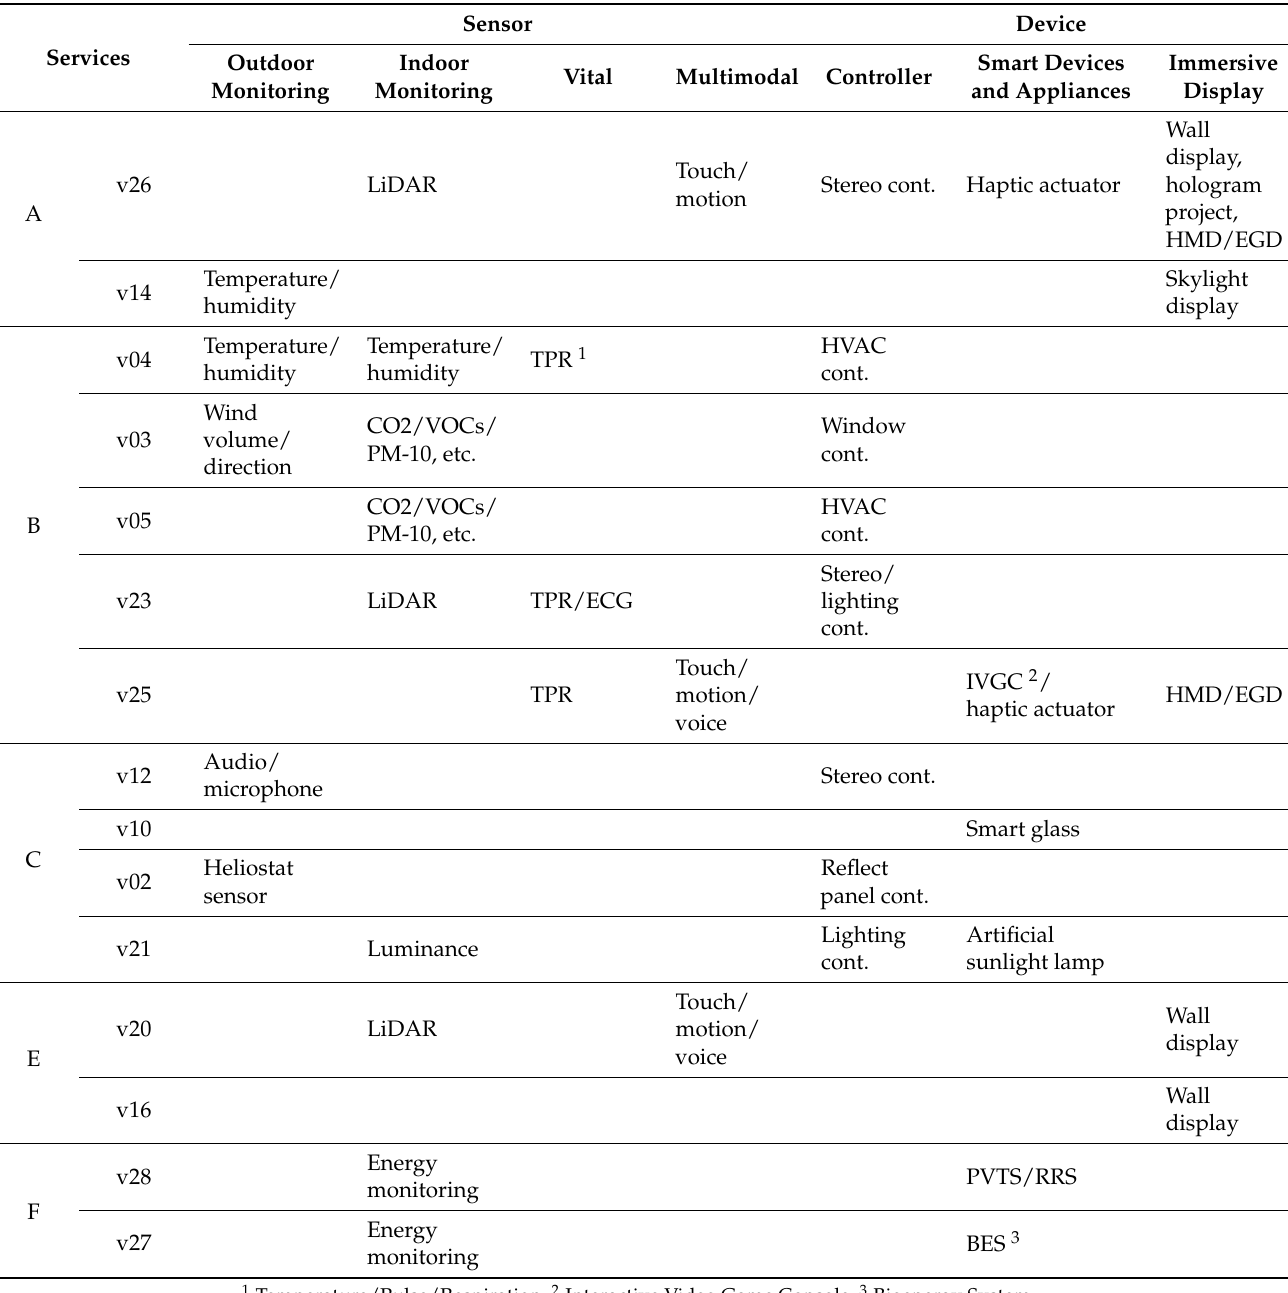
Table 8. Composition of biophilic experience based SHSs for the